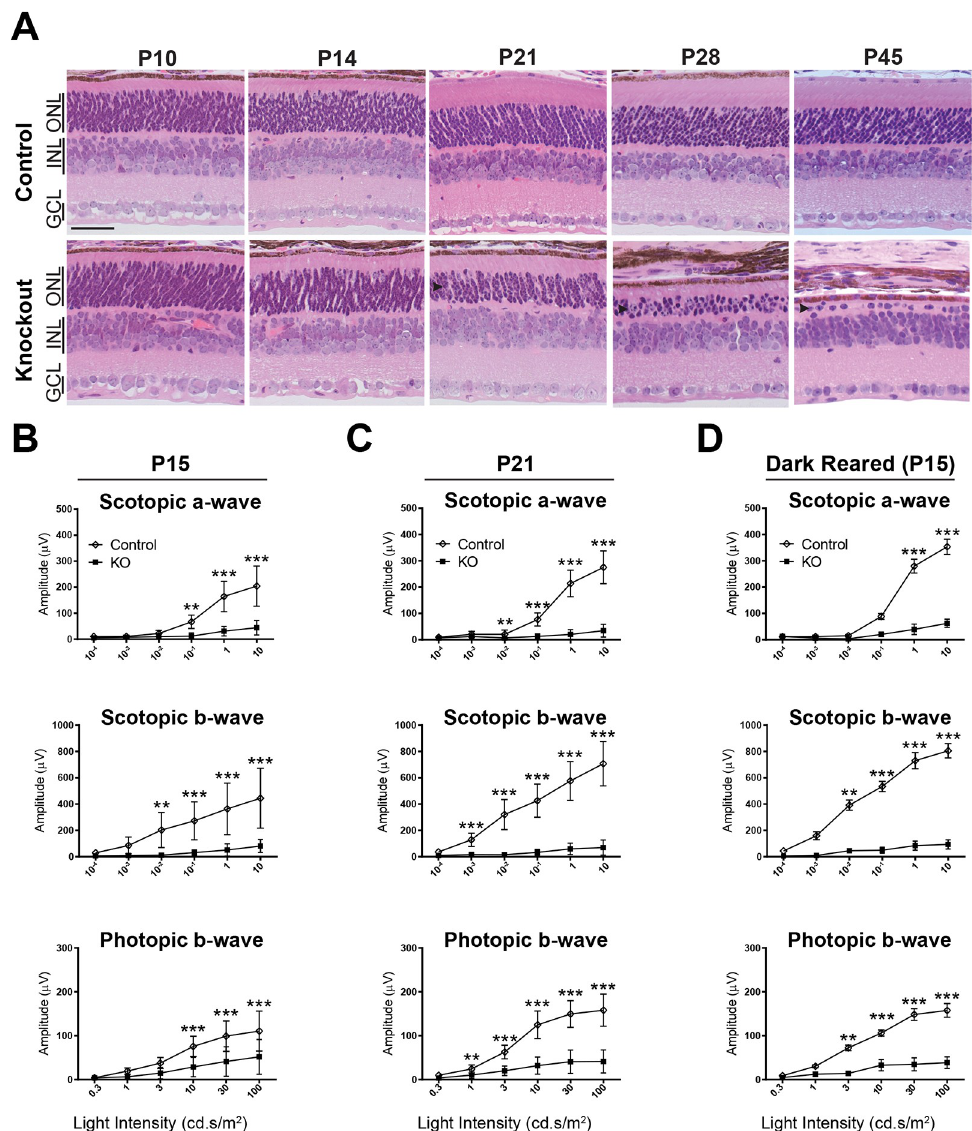
Fig 2. Rapid photoreceptor degeneration and loss of visual function in Rabgef1 -/- mice. (A) H&E staining of developing control and Rabgef1 -/- retina, showing near complete ablation of photoreceptors (ONL) by postnatal day 45. Scale bar = 50 μ m. ONL, outer nuclear layer; INL, inner nuclear layer; GCL, ganglion cell layer. (B, C) ERG stimulus intensity-amplitude functions in the control and KO mice reared in a 12h light/12h dark cycle and measured at postnatal day 15 and 21 (P15, P21), respectively. (D) ERG stimulus intensity-amplitude functions in control and Rabgef1 -/- mice born and raised in the dark. Dark-reared Rabgef1 -/- mice have similar ERG stimulus intensity-amplitude functions as animals reared in cyclic light. Asterisks indicate p-value < 0.05 ( � ), < 0.01 ( �� ) and < 0.001 ( ��� ) as determined by a t-test using Prizm software. In panels B and C, n = 7–10 per genotype and in D, 2–3 per genotype. Error bars indicate